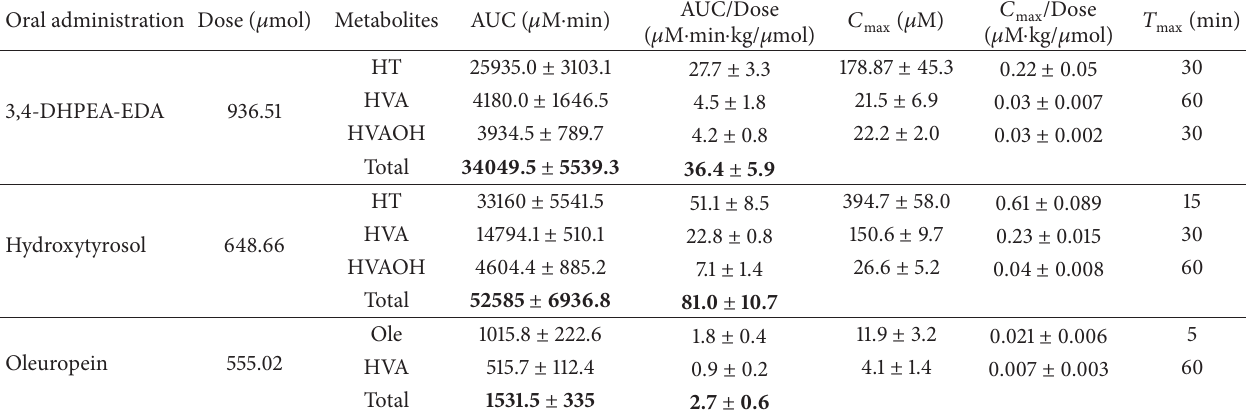
Table 2: Pharmacokinetic parameters after oral administration of 3,4-DHPEA-EDA, hydroxytyrosol, and oleuropein. Oral administration Dose ( 𝜇 mol)